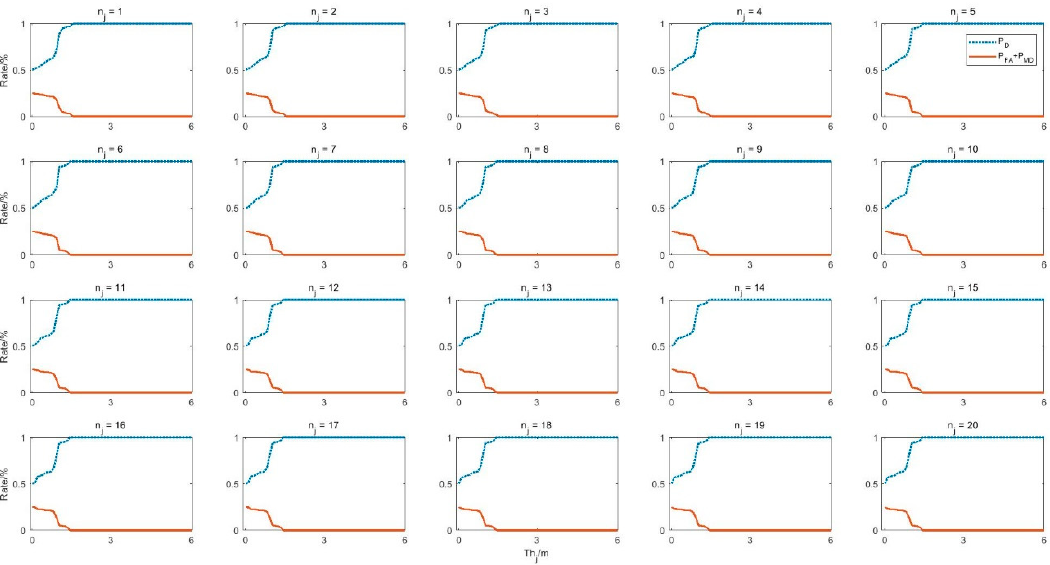
Figure 9. The influence of jump parameters on accuracy rate, false alarm rate and missing alarm rate.